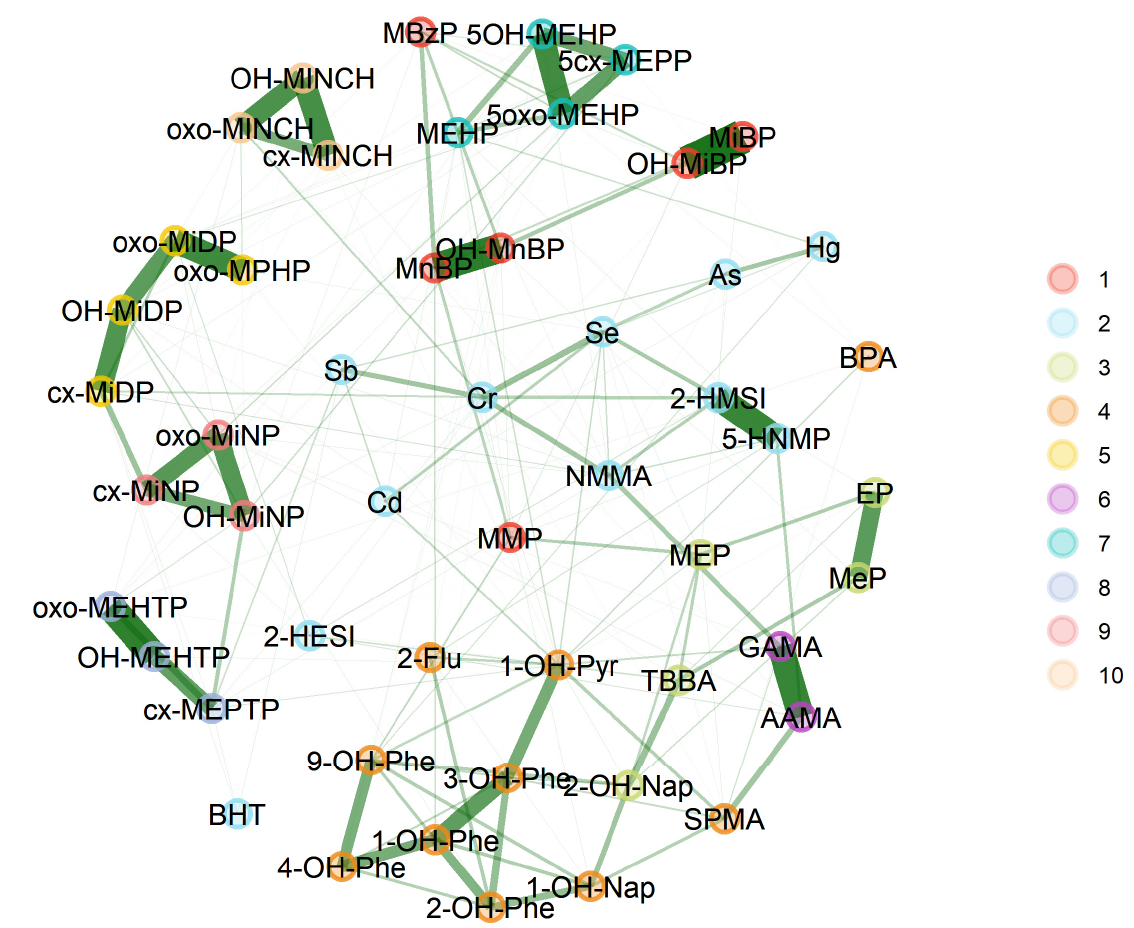
Figure 10. Weighted network for GerES V subsample, using creatinine-standardised and creatinine- adjusted data. Data were corrected for age and BMI. Green lines represent a positive dependency between nodes (biomarkers).